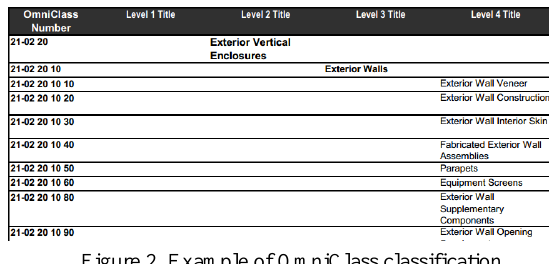
Figure 2. Example of OmniClass classification